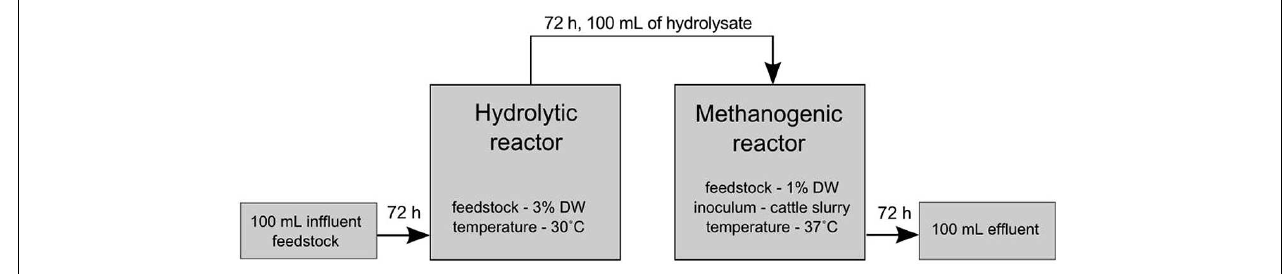
FIGURE 1 | Schematic presentation of the experimental set-up of the two-phase sequencing reactor of anaerobic digestion. Hydrolysis was carried out at 30 ◦ C for 72 h and anaerobic digestion was performed in a separate reactor at 37 ◦ C for 21 days. TABLE 1 | Identification and characterization of the isolated bacteria. Phylogenetic position (based on the analysis of the 16S rDNA sequence) Best match in GenBank database (accession number) Identity